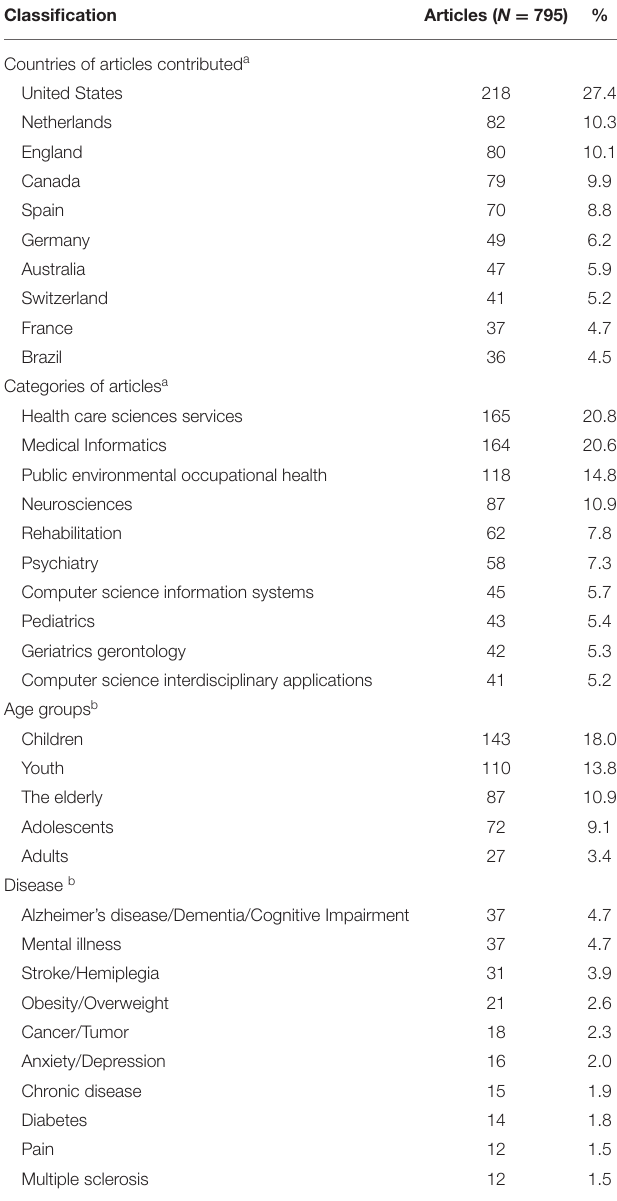
TABLE 1 | Characteristics of eligible scoping review